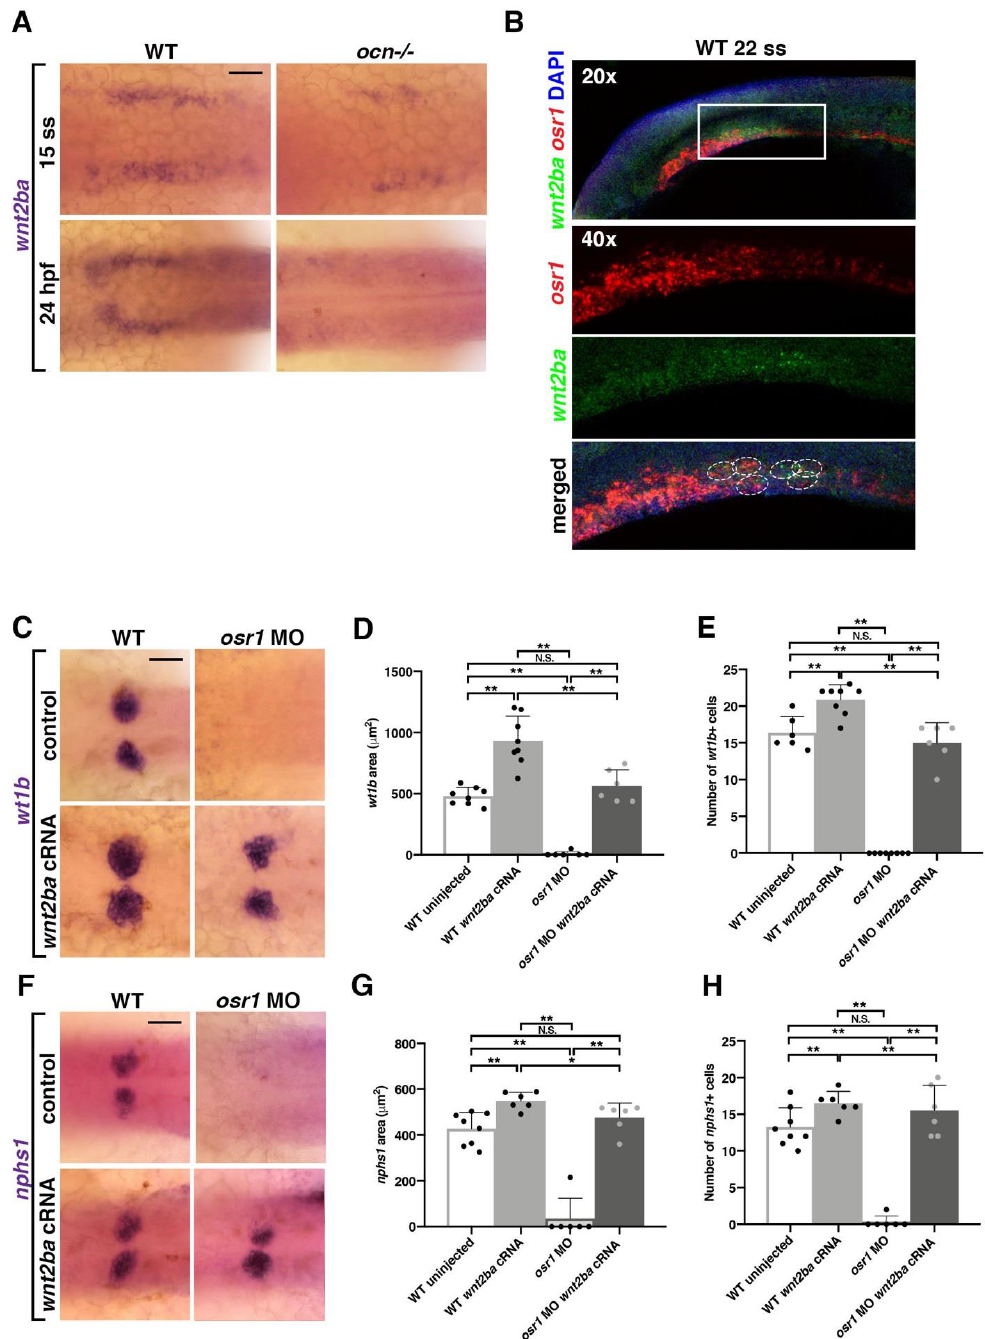
Figure 5. wnt2ba is sufficient for podocyte development downstream of osr1 . ( A ) When wnt2ba was assessed at 15 ss, in ocn − / − and WT siblings, it was evident that staining was reduced in mutants. By 24 hpf, wnt2ba staining was almost completely absent, tracking with the loss of other podocyte markers in ocn − / − . Scale bar is 30 µ m. ( B ) FISH experiments showed that osr1 and wnt2ba colocalized in cells at 22 ss. ( C – H ) Embryos were injected with osr1 MO and/or wnt2ba cRNA at the one-cell stage, and podocytes and the developing slit diaphragm were visualized at 24 hpf using wt1b and nphs1 , respectively. Embryos injected with osr1 MO alone showed few podocyte or slit diaphragm cells, while embryos injected with wnt2ba cRNA alone had an increased podocyte area. Coinjected embryos had a partial rescue of podocytes, indicating that wnt2ba is a downstream factor in the podocyte pathway. A minimum of 5 individuals were imaged for quantification. p -values: ** p < 0.001, * p < 0.05, N.S. = not significant. Scale bar is 30 µ